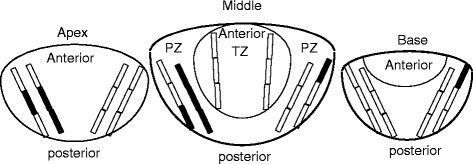
Histological localization diagram in a 67 year-old man with 6 positive cores in 14-core prostate biopsy, showing positive segments in cores as bars painted in black (TZ, transition zone; PZ, peripheral zone); each core was histologically assessed in 3 divided core segments.